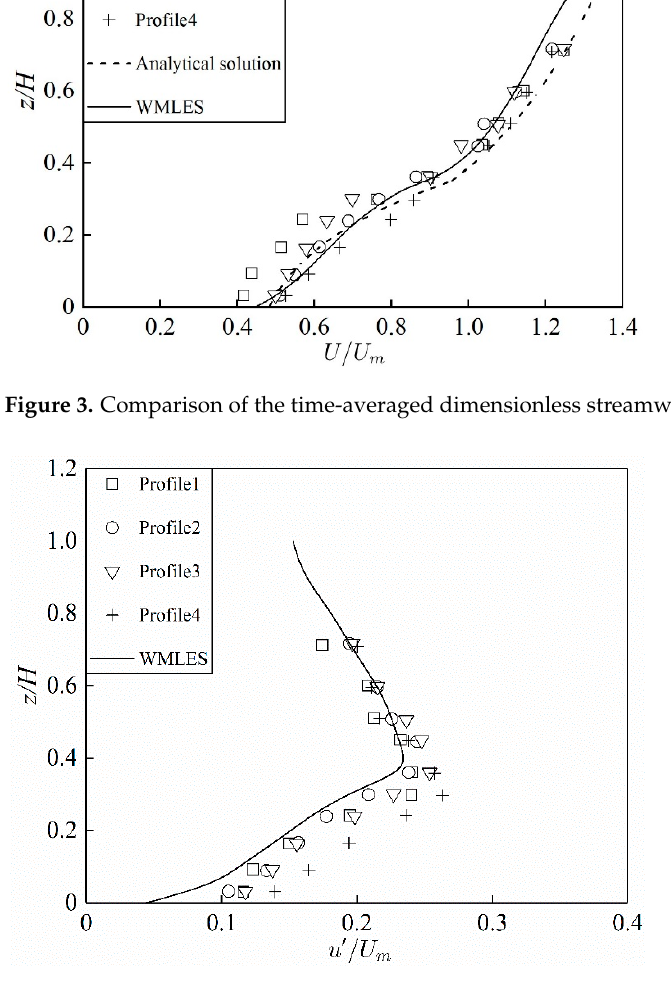
Figure 4. Comparison of dimensionless fluctuating flow velocity.